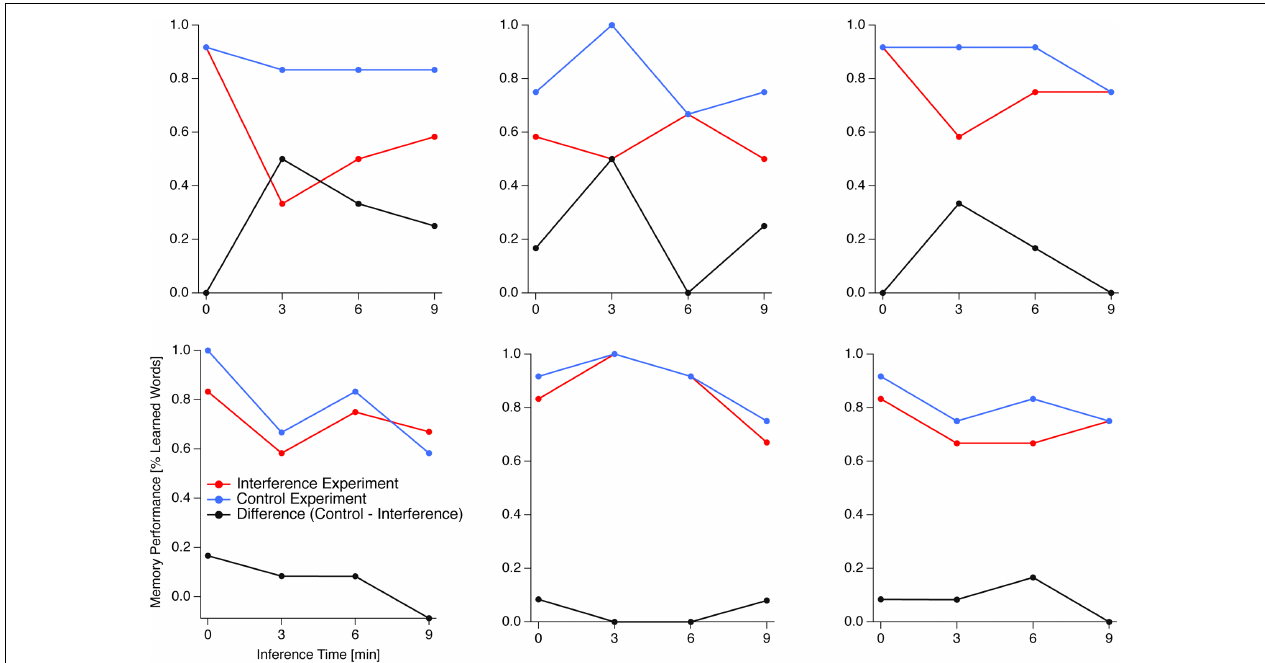
FIGURE 4 | Temporal profile of retroactive interference (individual examples). Memory performance in the interference experiment (red traces) and the control experiment (blue traces) together with difference traces (control minus interference data; black traces) of six example participants. For five of the six participants the interference effect has a single maximum, which can be located at different interference time points. One participant (bottom middle) shows two peaks at the beginning and at about 9 min after the learning unit. Also effect sizes can differ considerably (compare top and bottom rows).